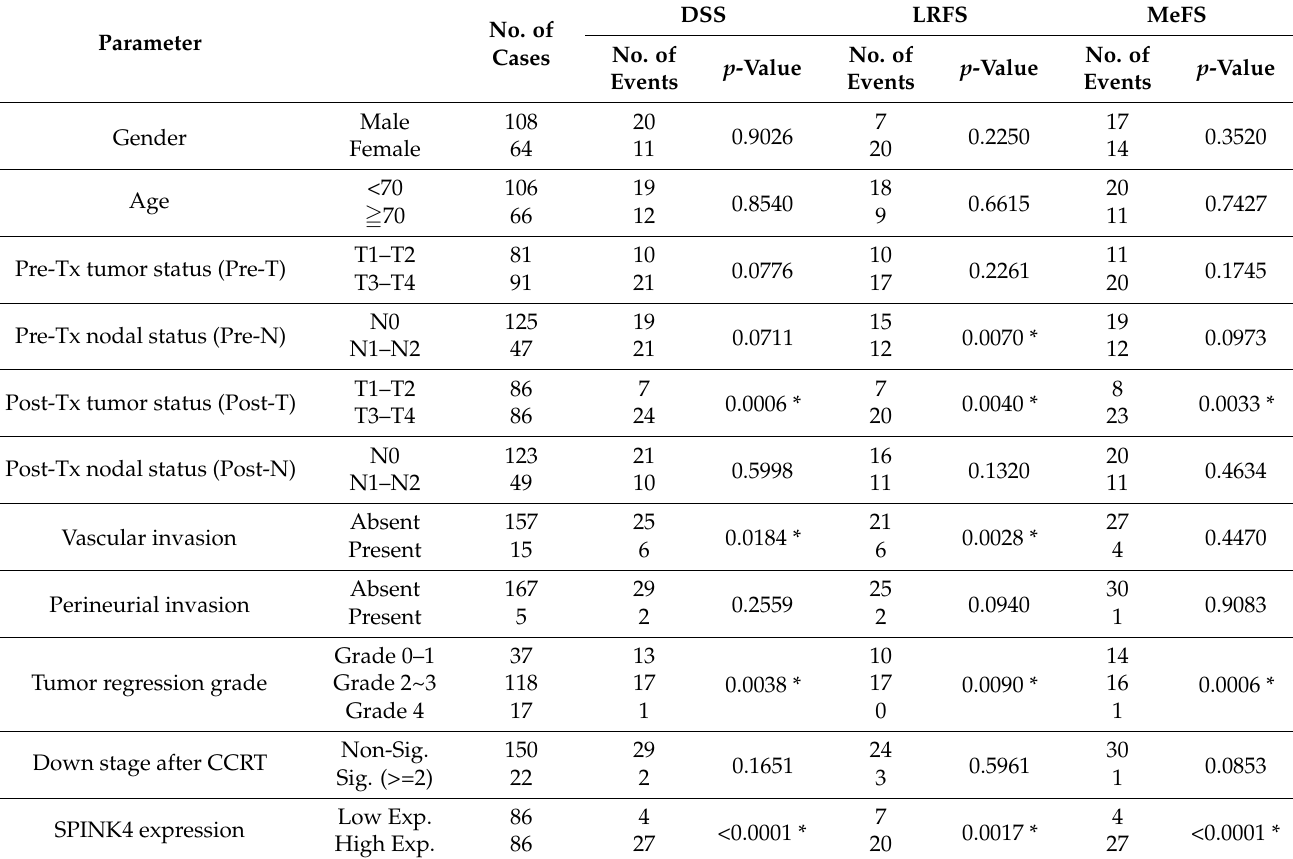
Table 3. Univariate log-rank analyses for important clinicopathological variables and SPINK4 expression.